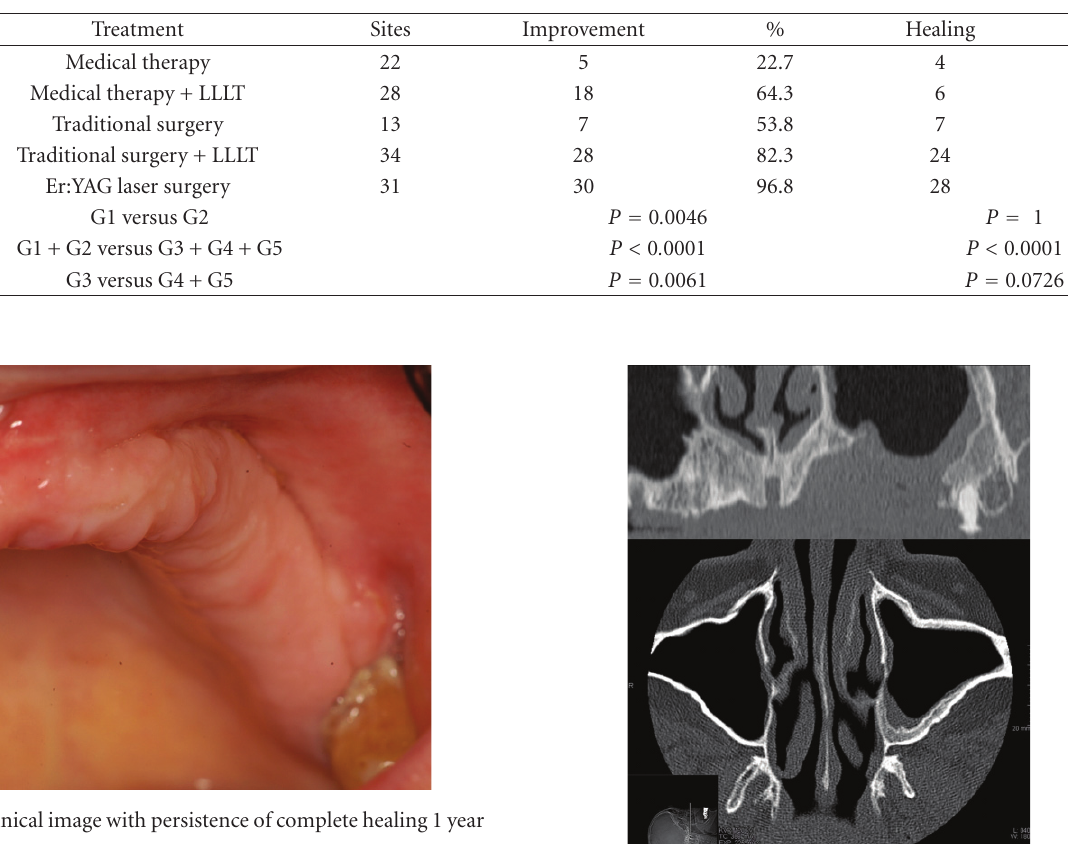
Table 5: Clinical results and statistical analysis in cancer patients in terms of clinical improvement and complete healing. Statistical analysis in cancer patients: comparison between nonsurgical nonlaser-assisted approach (G1) and nonsurgical laser-assisted approach (G2) and comparison between nonsurgical approach (G1 + G2) and surgical approach (G3 + G4 + G5).